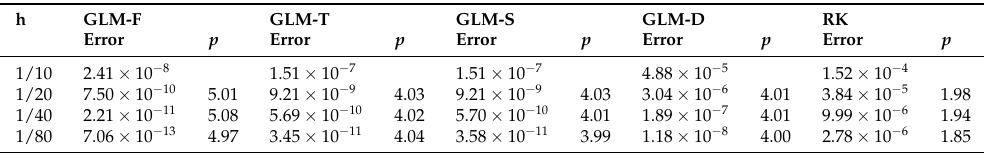
Table 1. Multivalue collocation and almost collocation methods, instead, keep their order of convergence. Table 1. Absolute errors in the final step point and experimental orders of convergence for prob- lem (18) with λ = − 10 6